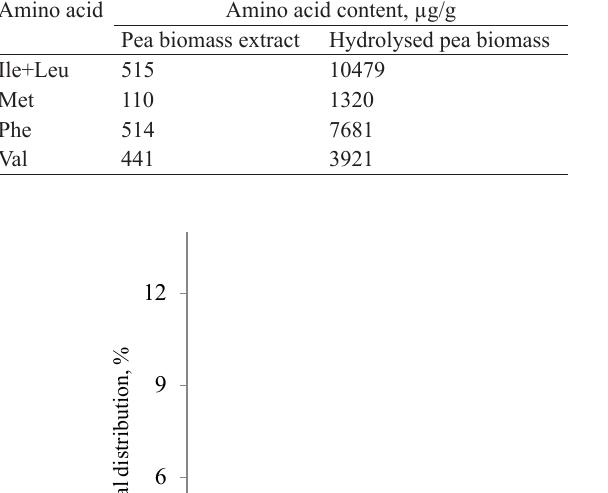
Table 4 Content of essential amino acids in the hydrolysate